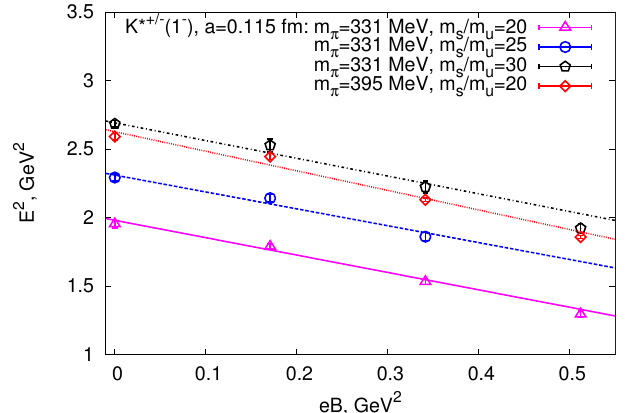
Figure 6. The energy squared of K (cid:3)(cid:6) meson with the spin projection s z = (cid:6) 1 versus the magnetic (cid:12)eld value for the lattice volume 18 4 , the lattice spacing 0 : 115 fm and various light and strange quark masses. Points correspond to the lattice data, lines are the (cid:12)ts to our data obtained using function (3.2).